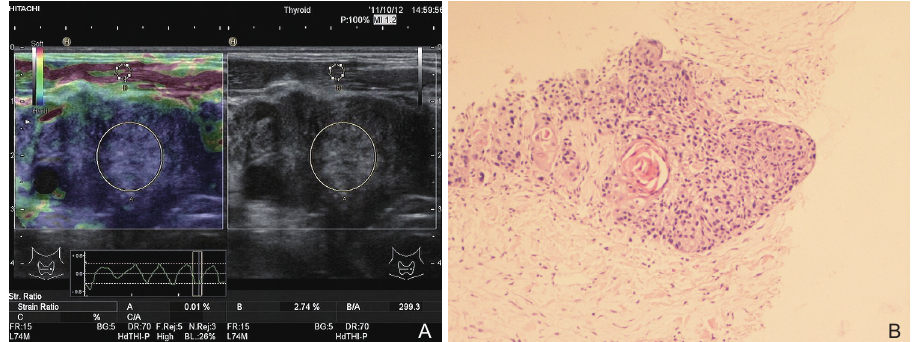
Figure 1 Conventional ultrasonography of the right lobe of thyroid gland showed a huge heterogeneous hypoechoic, microlobulating, solid mass, with blurred margin and microcalcifications and an apparently defective thyroid capsule (A). Color Doppler flow imaging showed the mass had little blood at the edge (B) and power Doppler examination showed patterns II of blood (C). Grayscale ultrasound scan showed several lymph nodes with suspicious hypoechoic features in the right neck